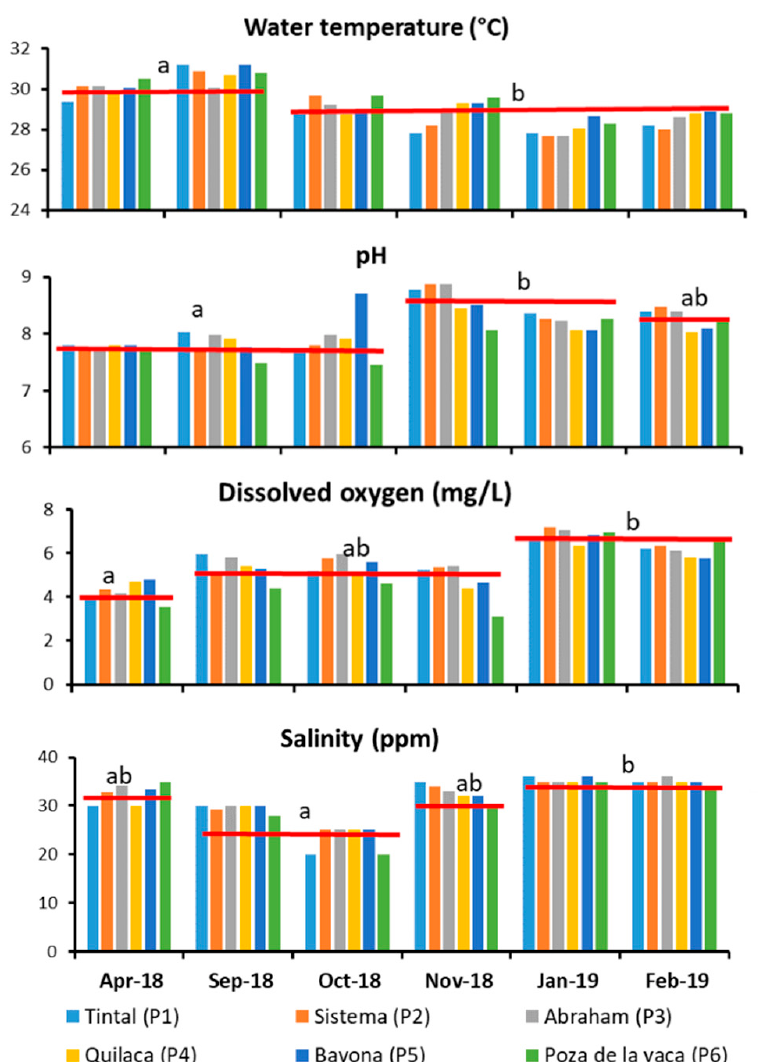
Figure 2. Physicochemical variables measured in the six sites of the Estero del Padre Ramos. Red lines show the mean of each different group based on the ANOVA results (Table S2; Supplementary material). The lower-case letters indicate significant differences in pairwise comparisons. Significant values when p < 0.001.